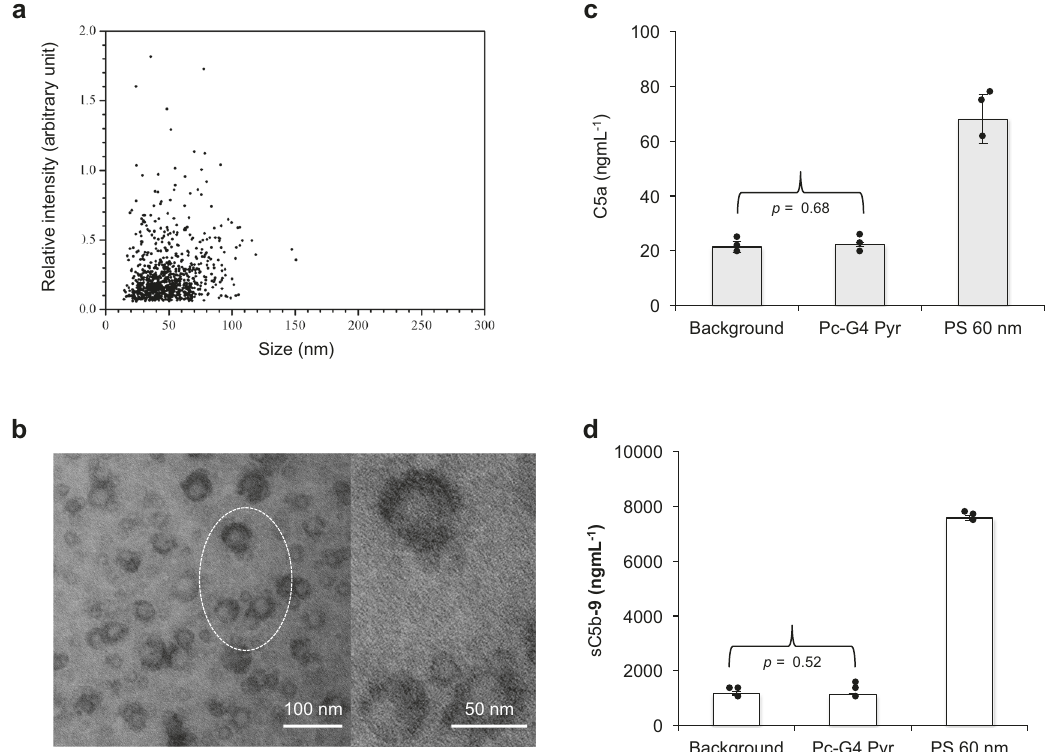
Fig. 5 Characteristics of Pc-G4 Pyr dendrimer complexes and their complement responses. a A typical NTA 2D plot of relative light scattering intensity of Pc-G4 Pyr particles versus the estimate of the nanoparticle size. The experiment was repeated three times with identical distribution pro fi le. A hydrodynamic size of 46± 3 nm (mean ± s.d.) was calculated from three independent determinations. b A representative transmission electron micrograph of Pc-G4 Pyr dendrimer complexes (left), and magni fi ed view of the highlighted region (right). The experiment was repeated three times with identical results. c , d Lack of complement activation by Pc-G4 Pyr dendrimer complexes (3.5 mgmL − 1 ) in a typical human plasma determined through measurements of fl uid-phase C5a and sC5b-9. A commercially available sulfated polystyrene nanoparticle suspension (PS) of 62± 6 nm (polydispersity index = 0.03 as determined by laser light scattering) was used as positive control for complement activation ( fi nal nanoparticle concentration = 3.5mgmL − 1 ). In c , d , each bar represents the mean ± s.d. of three separate experiments, and each dot indicates the mean of three technical replicates. Indicated p values are derived from unpaired two- sided student t -test. Source data are available in Source data fi